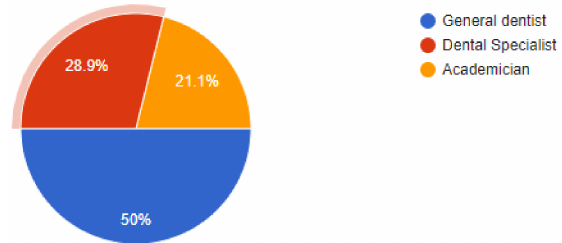
Figure 2. Percentage division by Profession of dentists.